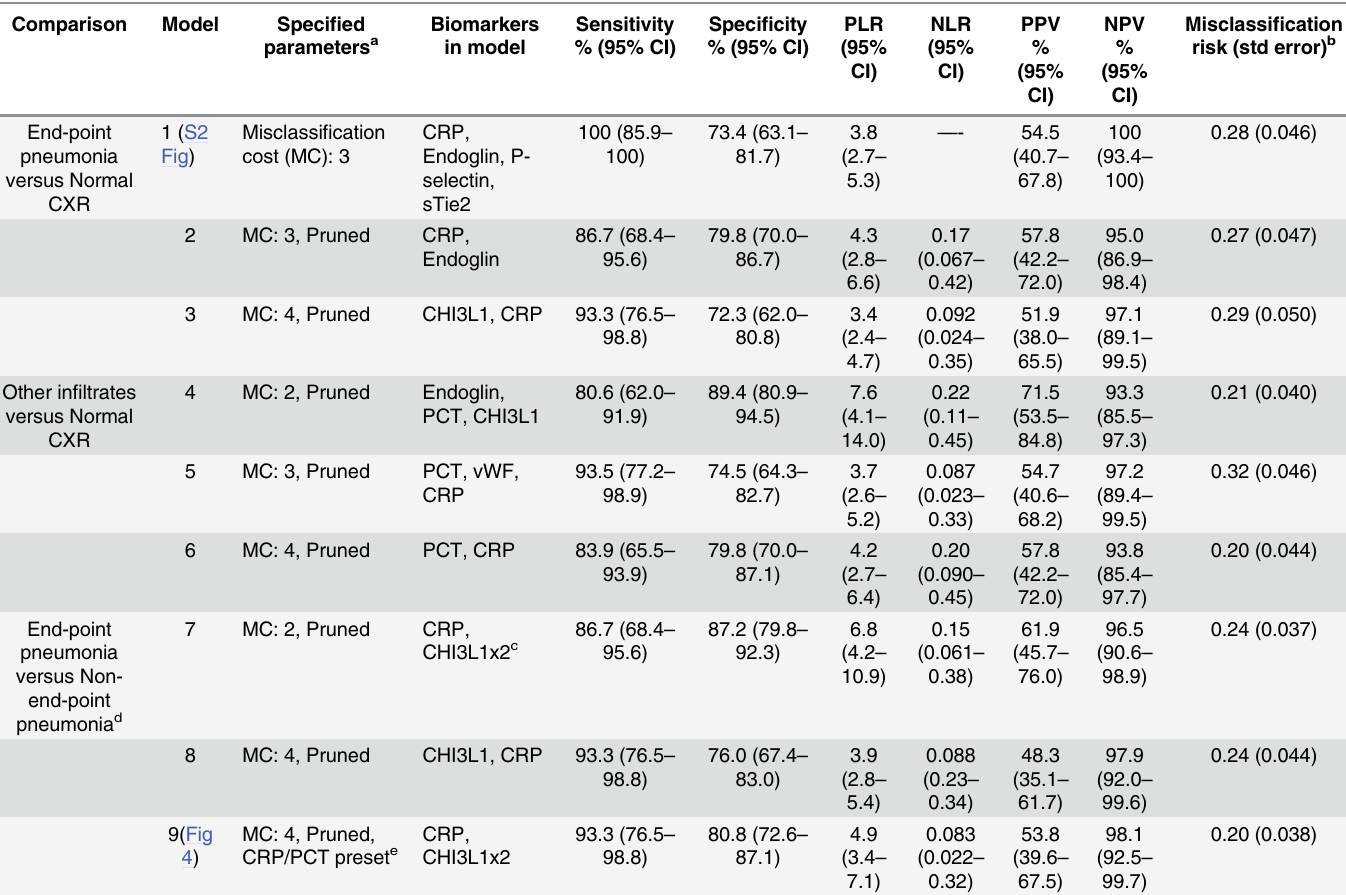
Table 3. Classification and Regression Tree (CRT) models classify children with clinical pneumonia based on radiological